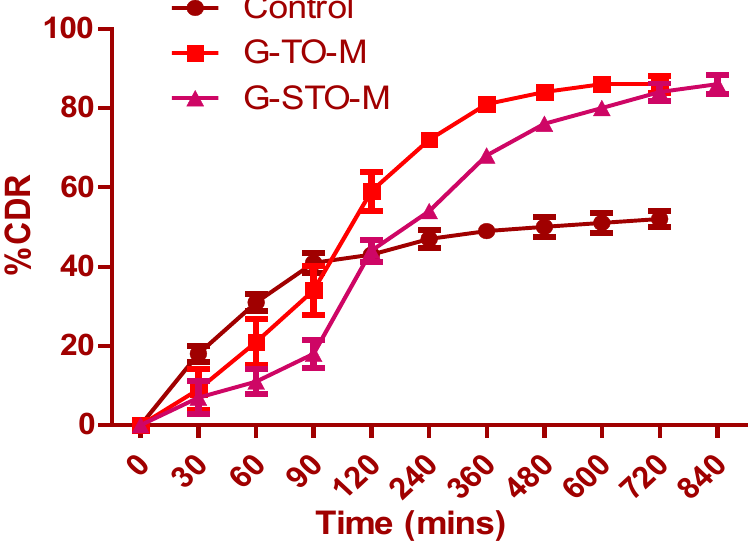
Figure 6. In vitro dissolution study for control (pure glibenclamide), G-TO-M, and G-STO-M.